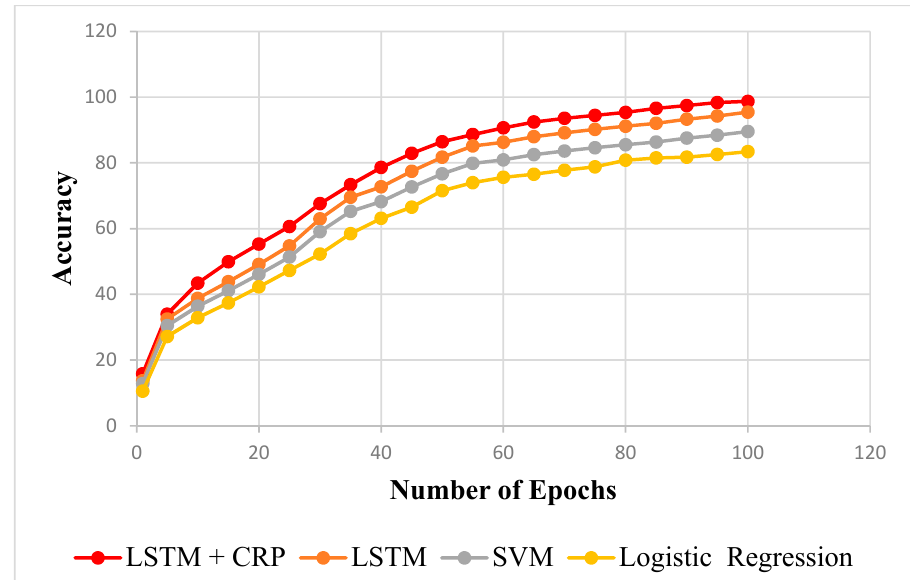
Figure 10. Train data R 2 comparison. Table 5. Multiple epochs of training data R 2 vs. various prediction techniques.